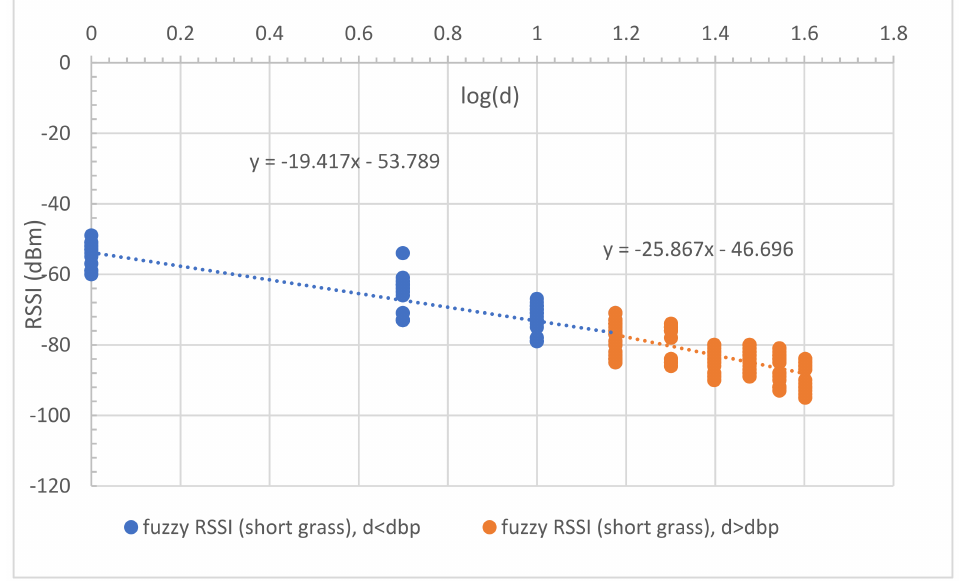
Figure 4. Uncertainty in observed RSSI and distance of short grass, for all antenna